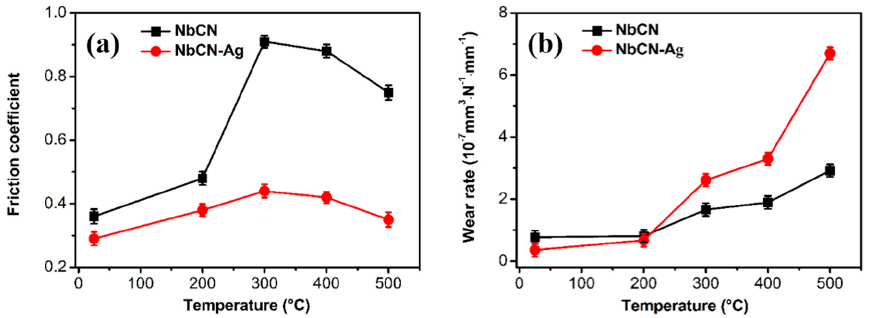
Figure 11. ( a ) Friction coefficients and ( b ) wear rates of NbCN and NbCN-12.9 at.% Ag film at different temperatures.